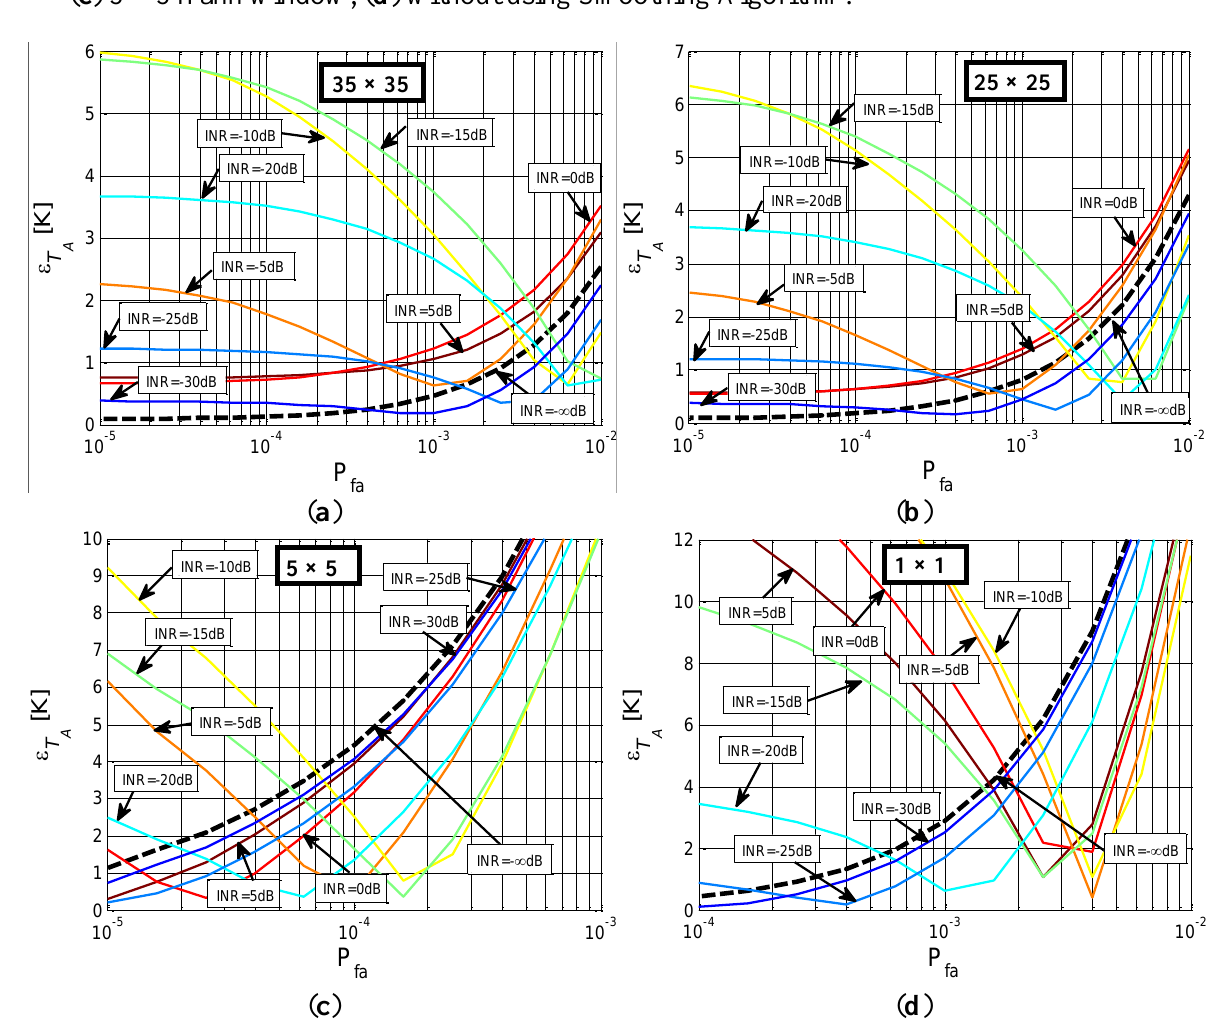
Figure 9. Error obtained by the Smoothing Algorithm in the retrieved T window as smoothing filter. ( a ) 35 × 35 Hann window; ( b ) 25 × 25 Hann window; ( c ) 5 × 5 Hann window; ( d ) without using Smoothing